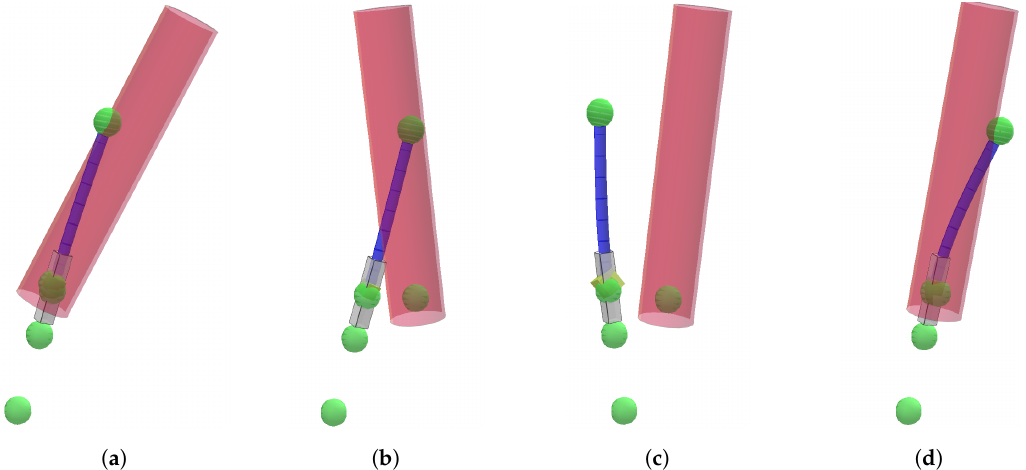
Figure 8. Schematic representation of the system motions in the three rigid body modes ( a – c ) and the first flexible mode of the stator beam ( d ).